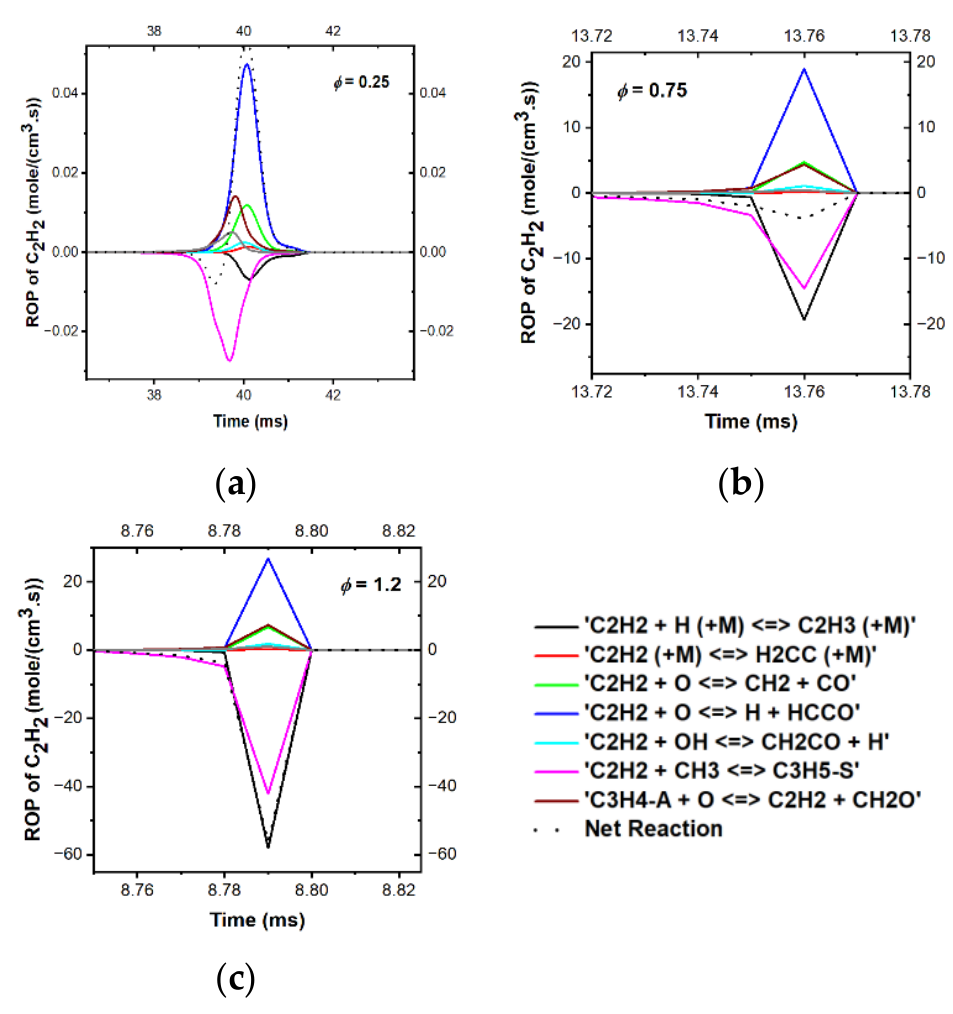
Figure 20. ROP analysis of C 2 H 2 for the oxidation of tert-butanol at ( a ) φ = 0.25, ( b ) φ = 0.75 and ( c ) φ = 1.2.